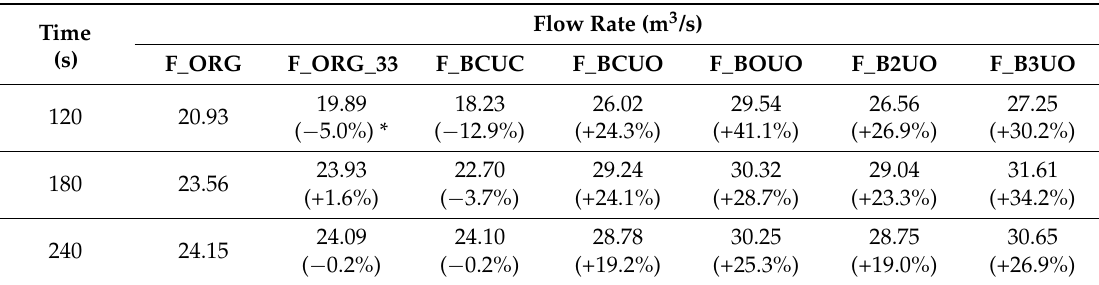
Table 8. Flow rate of the metal